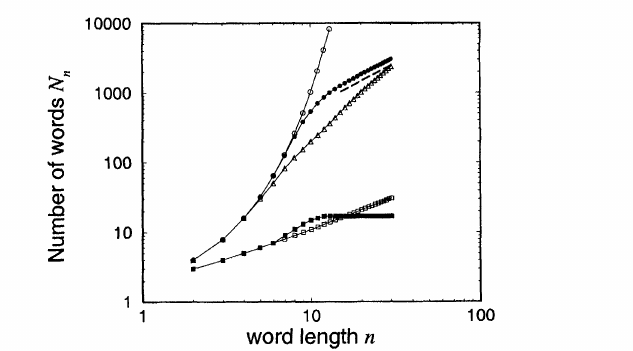
FIGURE 9 Characterization of complexity of the two-symbol symbolic sequence (filled circles). The dashed line has slope 1.27. For comparison we show the corresponding curves for the fully random sequence of two symbols (open circles), for a periodic sequence (filled boxes), and for quasiperiodic se- quences with two frequencies (open boxes) and with three frequencies (open triangles). In the latter two cases the number of words grows as power laws o( n and e( n 22,